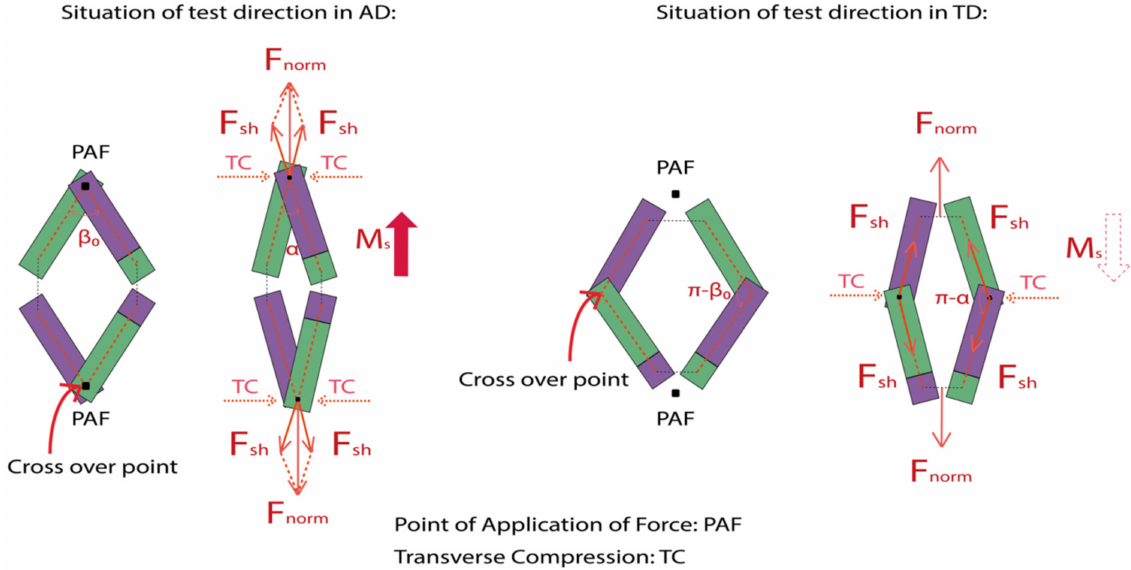
Figure 13. Scissor mechanisms in AD and TD for in-plane shear